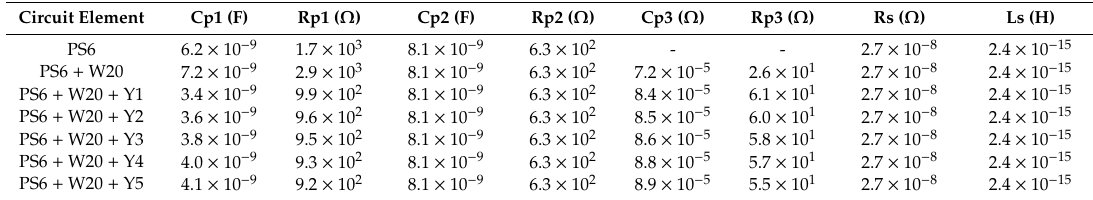
Table A10. Modeled impedance parameters Cp1, Rp1, Cp2, Rp2, Cp3, Rp3, Rs, and Ls of biochip PS6, with DI water and S. cerevisiae .